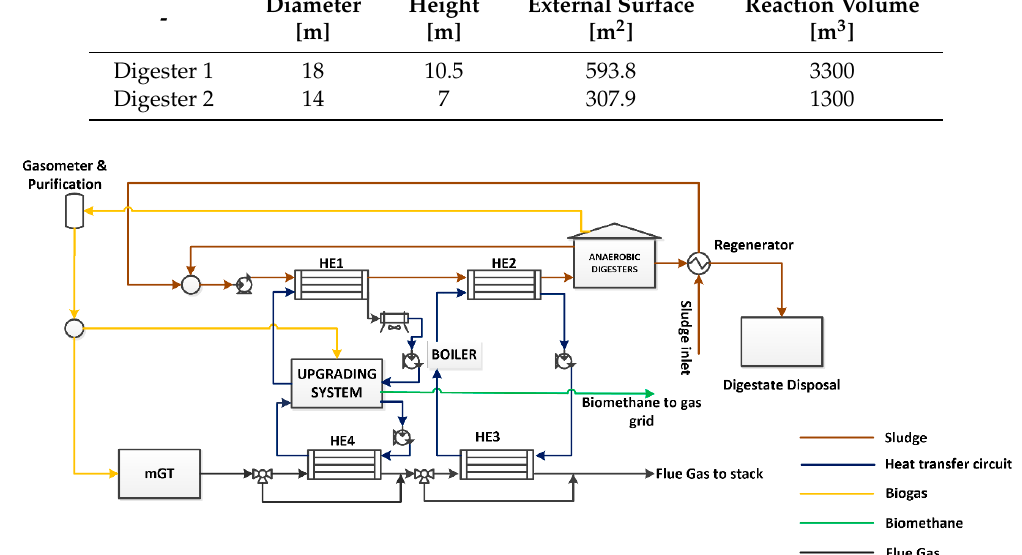
Figure 1. The scheme of the anaerobic digestion plant.